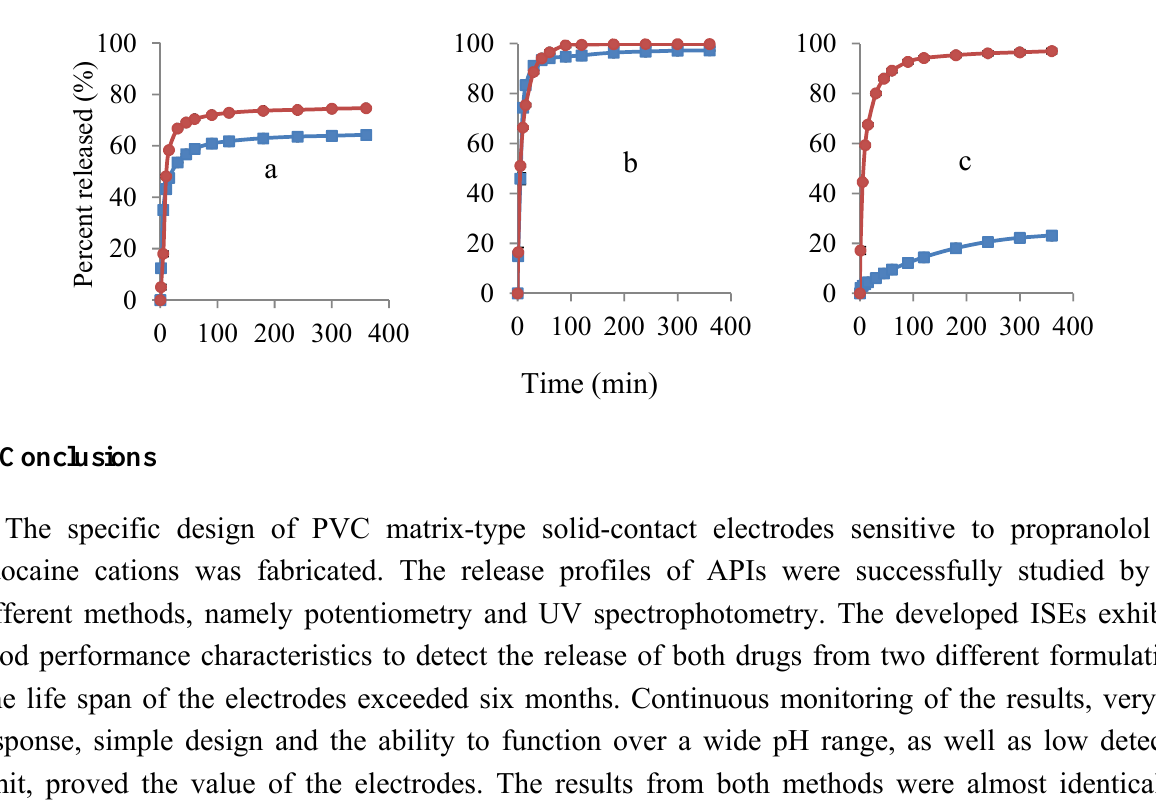
Figure 7. Release profiles of lidocaine hydrochloride from polymer films, using potentiometry with 20% ( ■ ) and 40% ( ● ) lidocaine in drug-polymer solutions. Ratios of EC:HPC in the polymer component are ( a ) 1:1; ( b ) 0:1 and ( c ) 1:0. Mean ± SD values are shown ( n =